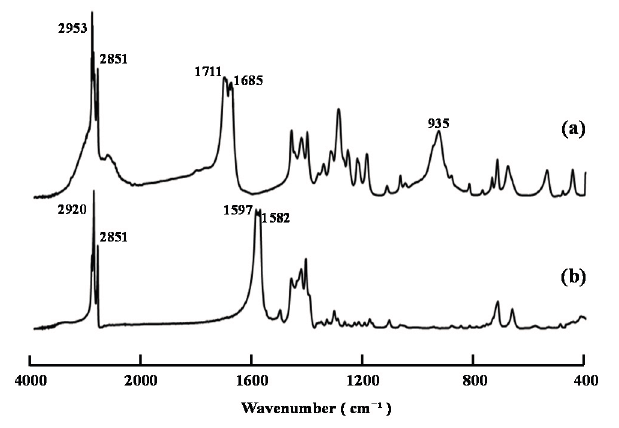
Figure 3. FT-IR spectra of (a) decanoic acid and (b) compound 5